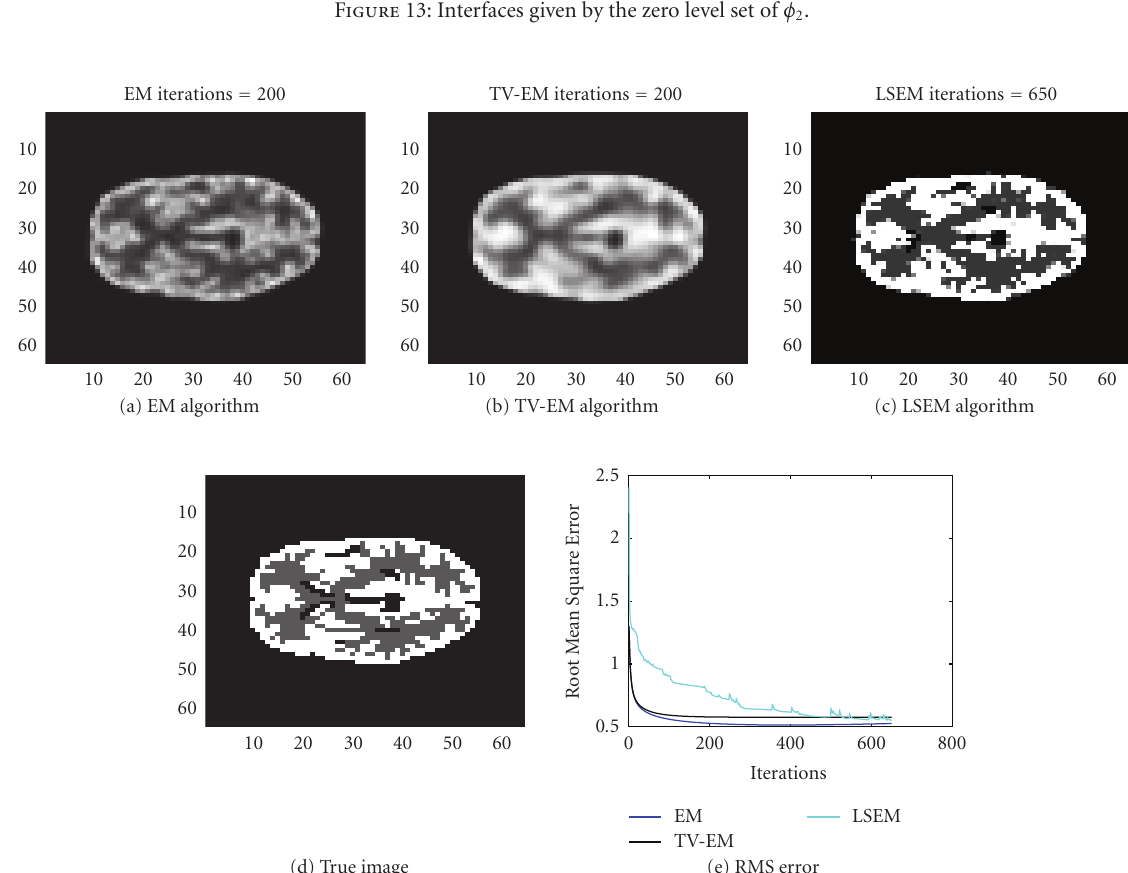
Figure 14: 64 × 64 segmented MRI slice of the